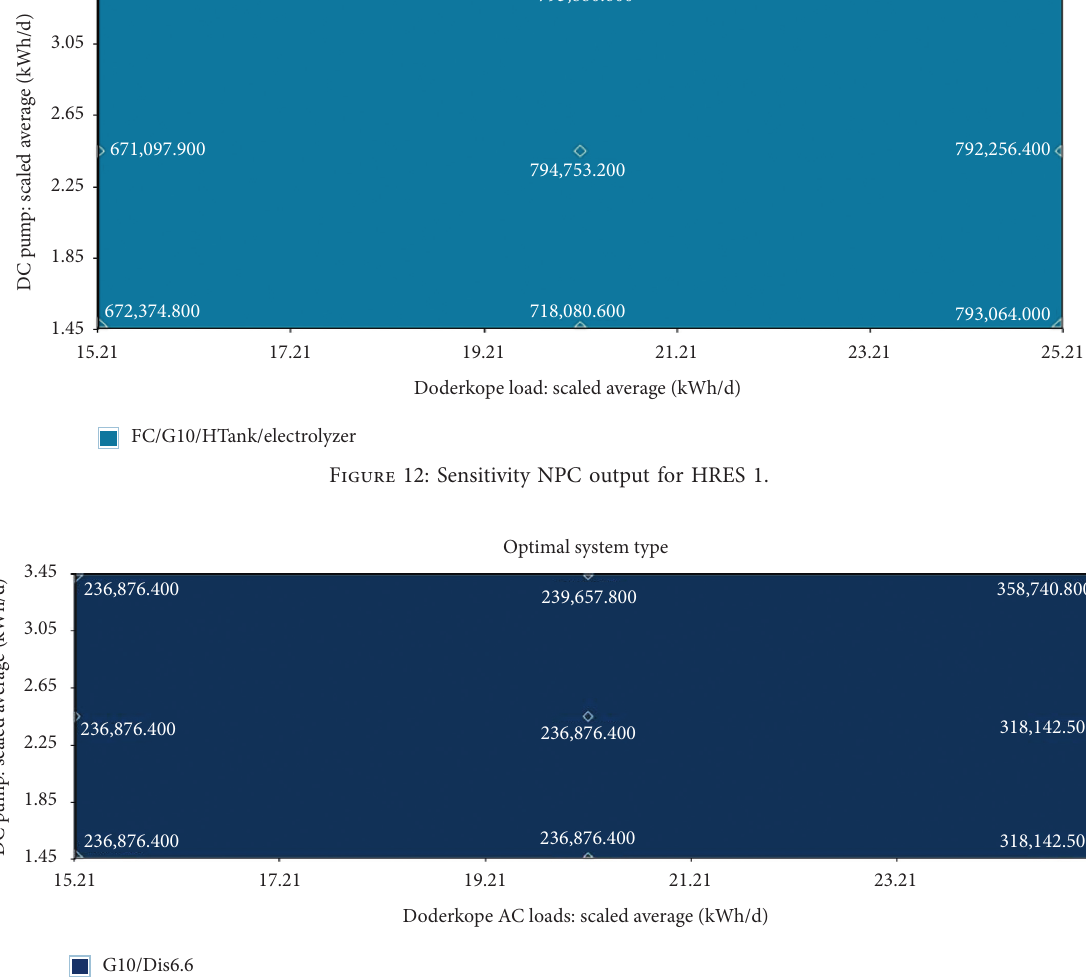
Figure 13: Sensitivity (NPC) of HRES 2. Optimal system type